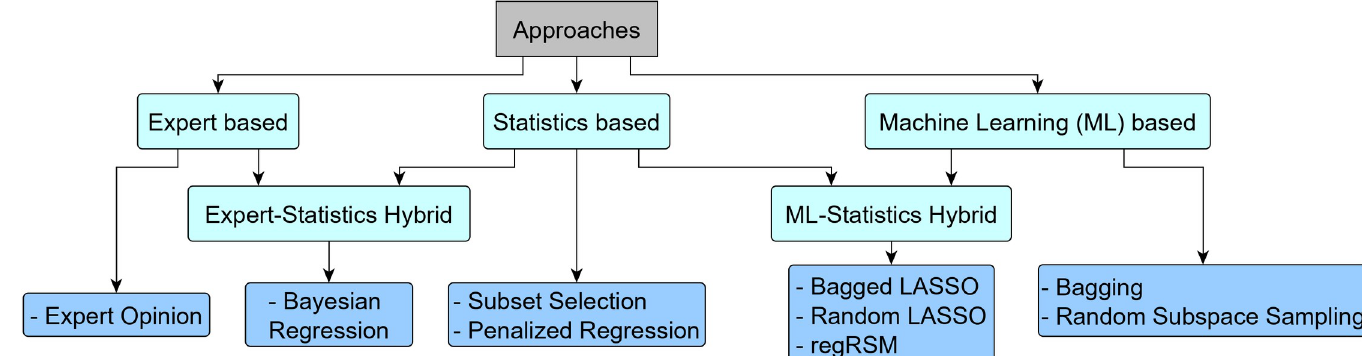
Fig 1. Feature selection approaches suggested in literature with